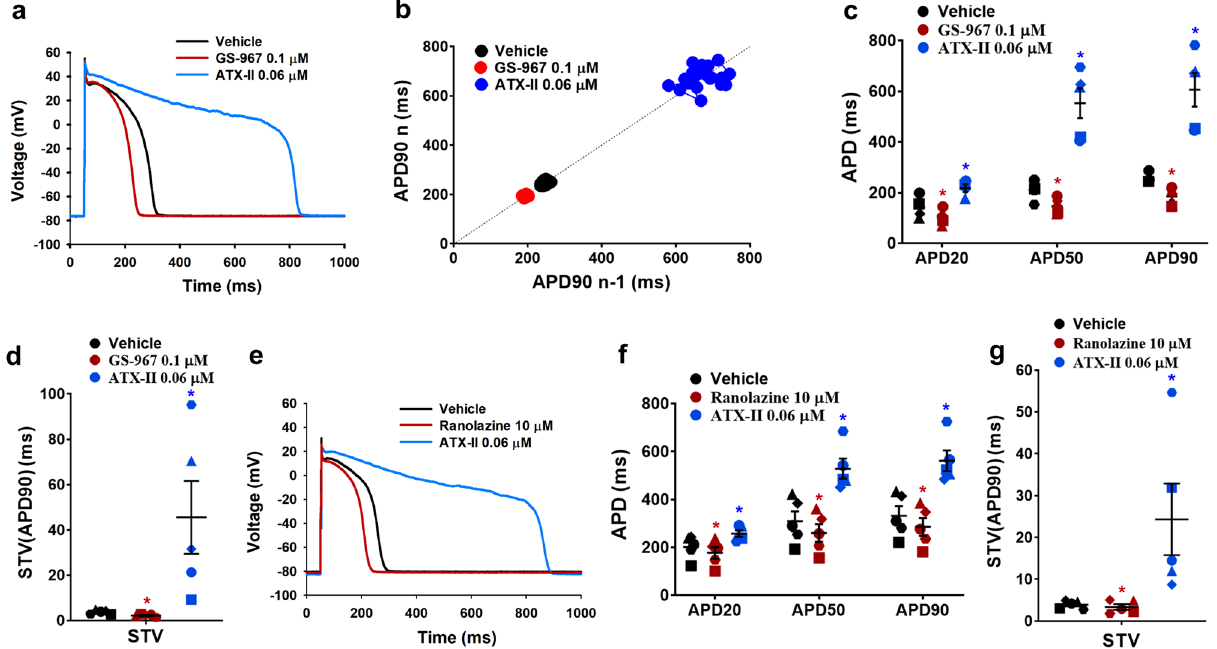
Figure 2. Physiological late INa and normal human ventricular action potential. ( a ) Typical action potentials (APs) recorded from a ventricular cell at a pacing of 1 Hz in the presence of vehicle control and after exposure to 0.1 µM GS-967 or 0.06 µM ATX-II. ( b ) shows a typical example of a Poincaré plot of APD90 from a ventricular cell (same cell as in a ) under vehicle and in the presence of GS-967 or ATX-II. Note the large complex polygons during the application of ATX-II. ( c ) and ( d ) show mean % changes in APD (measured at 20% (APD20), 50% (APD50) and 90% (APD90) of repolarization) and STV(APD90), short-term variability of APD90 (n = 5 cells). ( e ) Typical APs recorded from a ventricular cell at a pacing frequency of 1 Hz in the presence of vehicle control and after exposure to 10 µM ranolazine or 0.06 µM ATX-II. ( f ) and ( g ) show mean % changes in APD and STV(APD90) under vehicle and in the presence of ranolazine or ATX-II (n = 5 cells). *,* p < 0.05 versus values from vehicle control. Fitmaster analysis software package (HEKA Elektronik, Germany, www. heka. com) and SigmaPlot v14.0 (Systat Software Inc., CA, USA, www. systa tsoft ware. com) were used to generate the representative AP